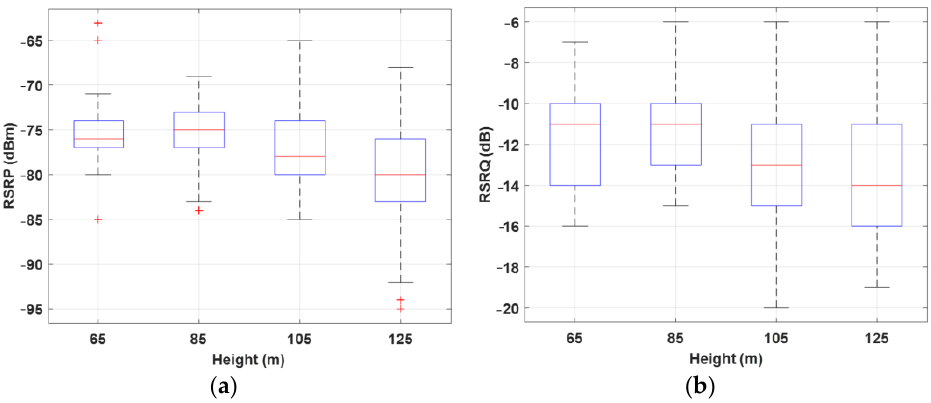
Figure 6. Box plot of ( a ) RSRP and ( b ) RSRQ for Route I at different heights, 65, 85, 105, and 125 m.